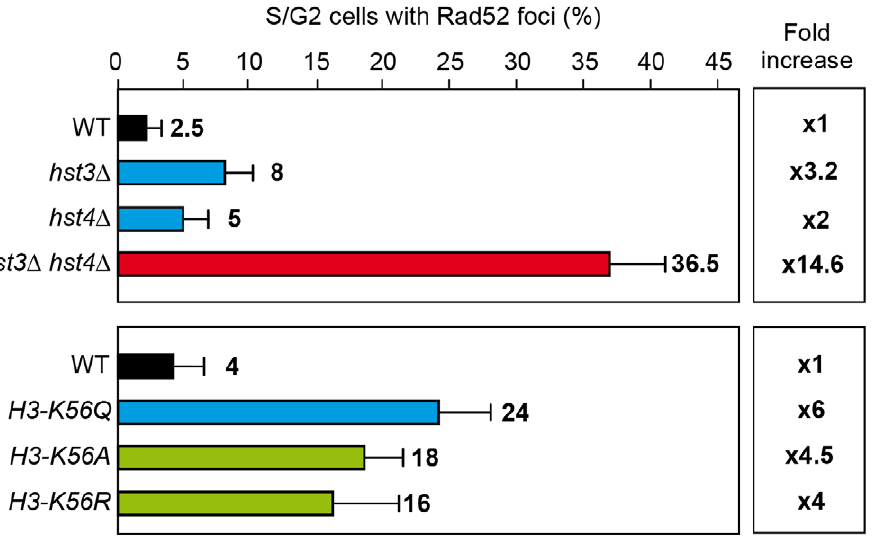
Figure 6. H3K56 acetylation increases DNA damage. Rad52 foci in different mutants affected in the histone H3K56 acetylation/deacetylation pattern. Average and standard deviation of two independent experiments are shown.